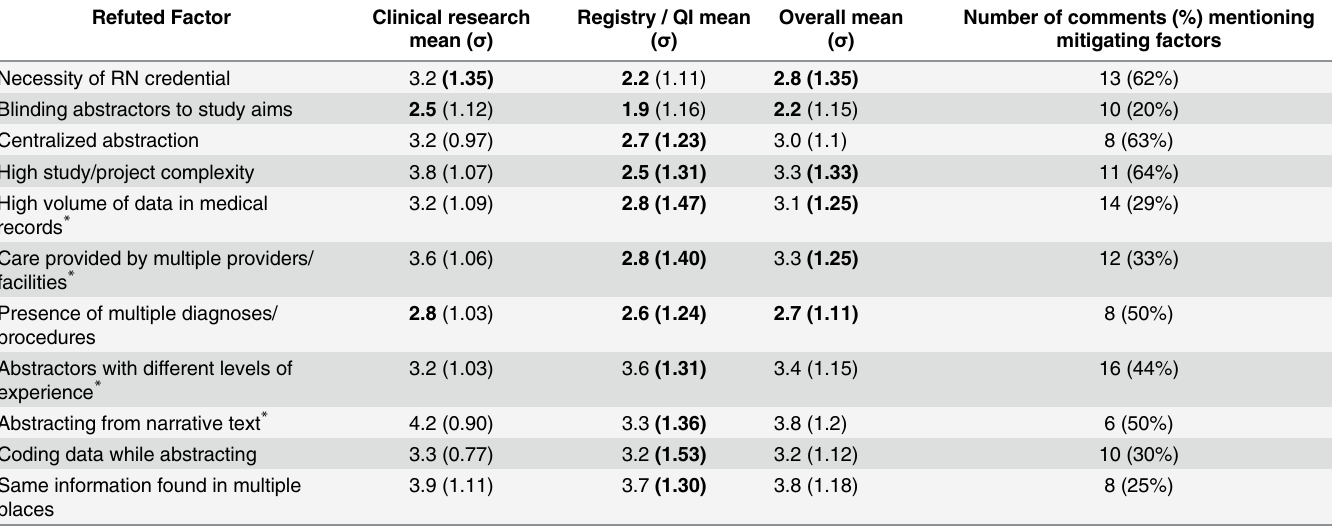
Table 4. Refuted and uncertain